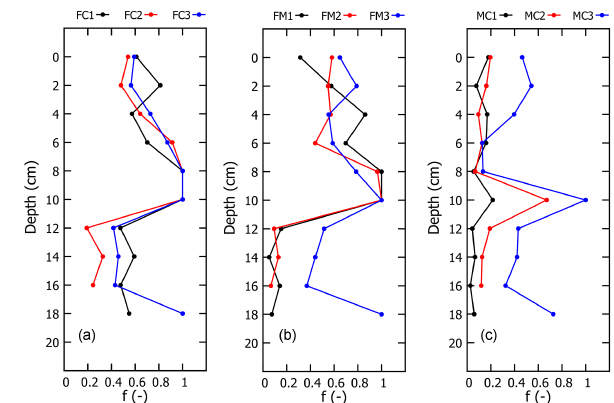
Figure 3. Measured f profiles. f is the ratio between wet and total area for all the sections in Fig. 1. (a) FC samples; (b) FM samples; (c) MC samples. The vertical coordinate refers to the depth of the section from sample top surface. Serial numbering 1–3 represent the three different input rates.